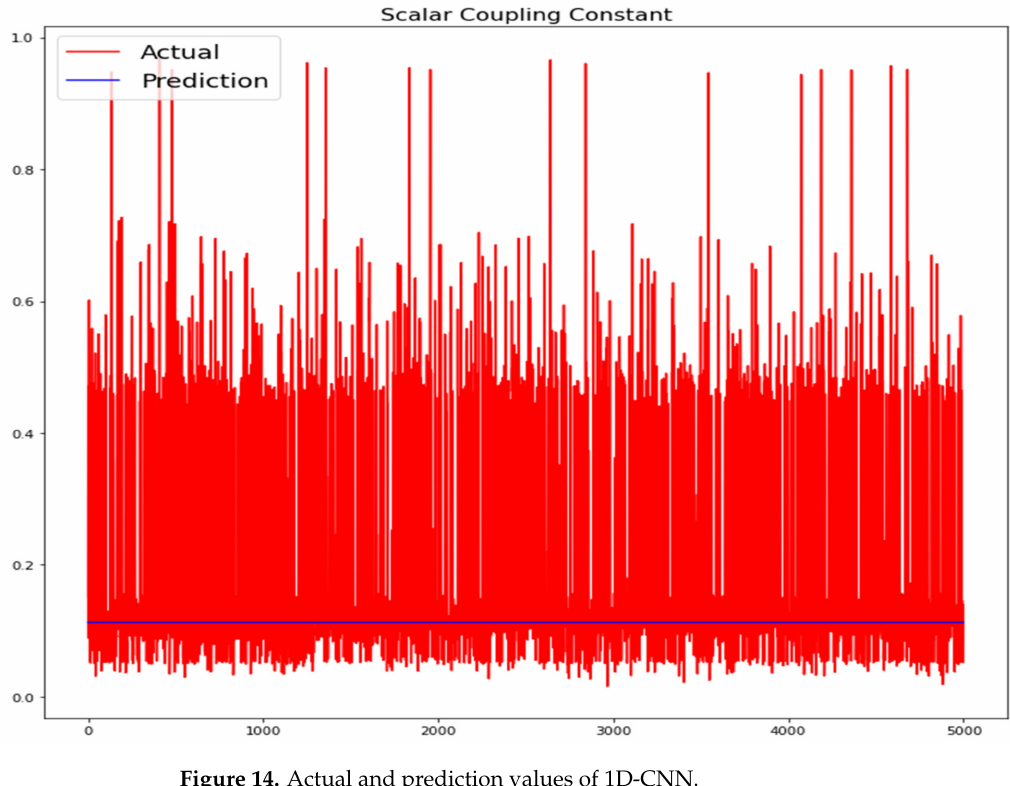
Figure 14. Actual and prediction values of 1D-CNN.